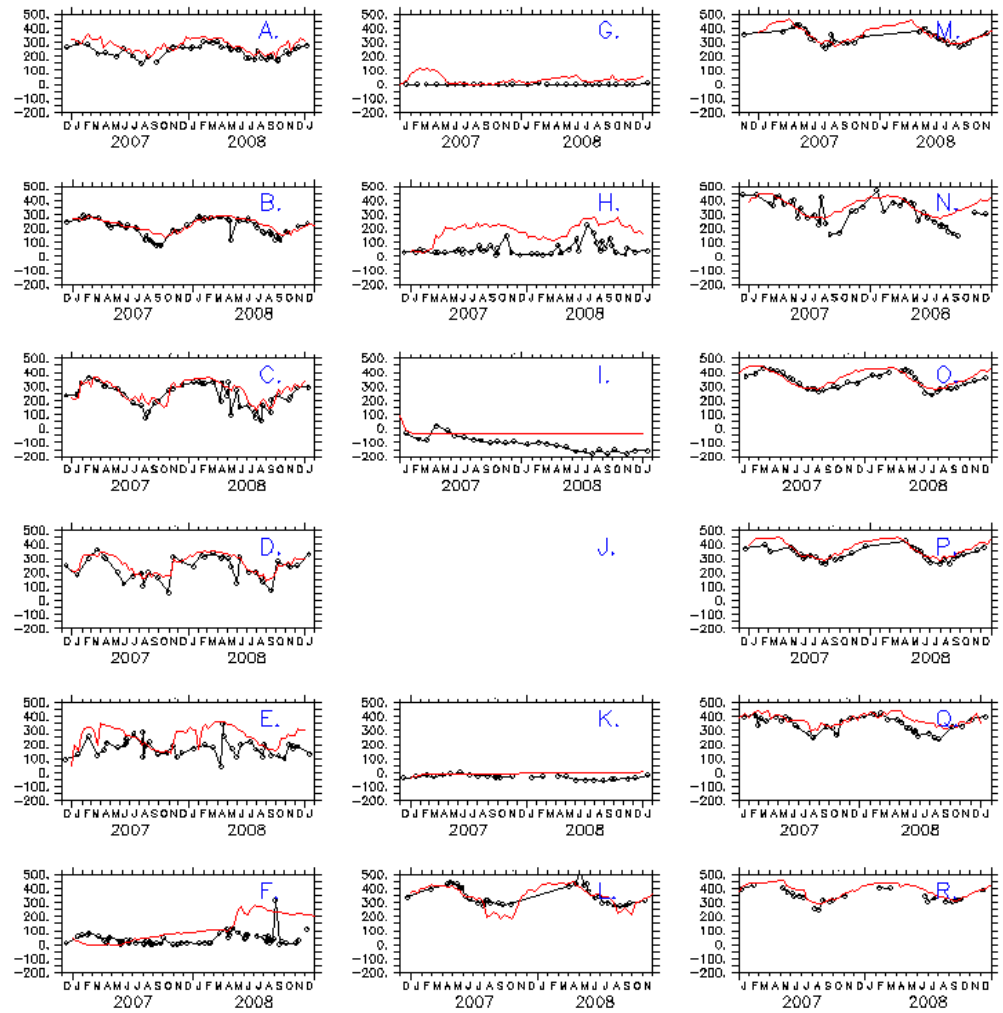
Fig. 12. Seasonal variability of DO in bottom layer. Notations same as in Fig.